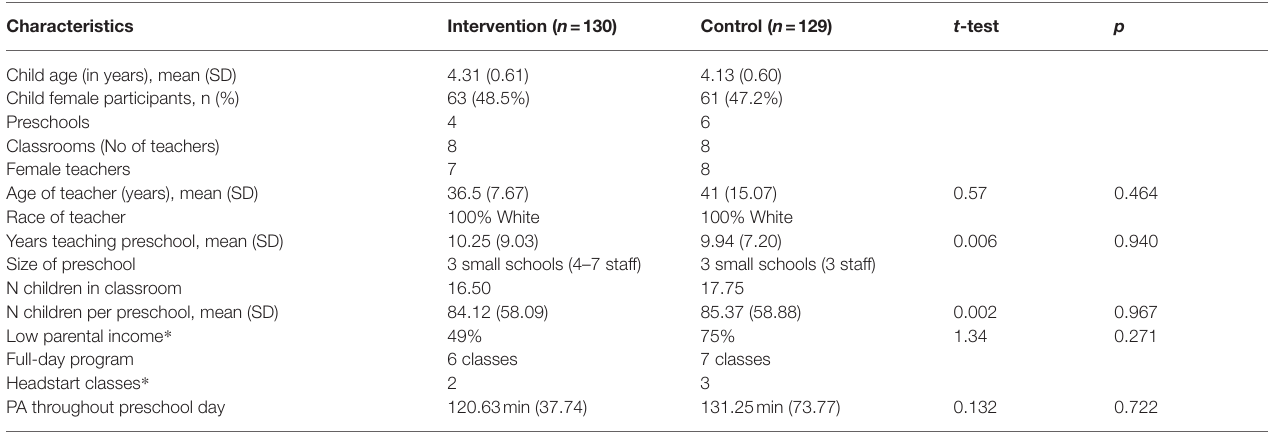
TABLE 1 | Baseline characteristics of study sample.